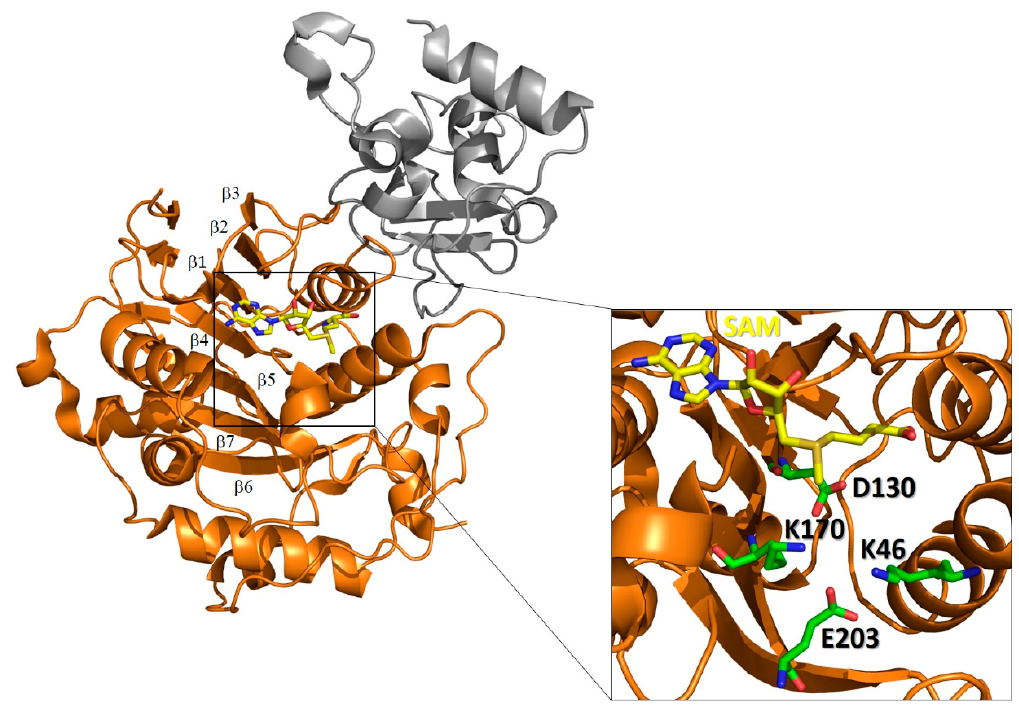
Figure 8. Structure of the SARS-CoV-2 Nsp10-Nsp16 complex. Cartoon representation of the crystal structure complex (PDB code 6W4H) of Nsp16 (orange) in complex with Nsp10 (grey). The inset shows the catalytic site of Nsp16. Catalytic residues (green) and the SAM ligand (yellow) are shown in stick form.